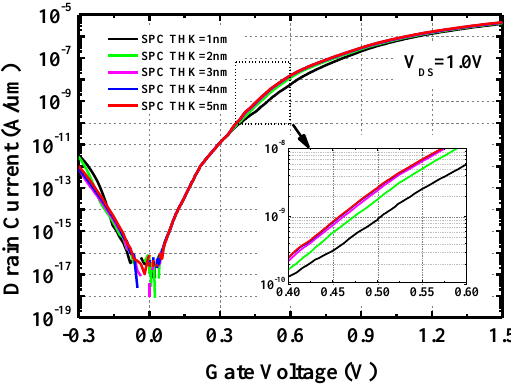
Figure 4. Transfer characteristics with various spacer thickness (1–5 nm) based on κ = 25.